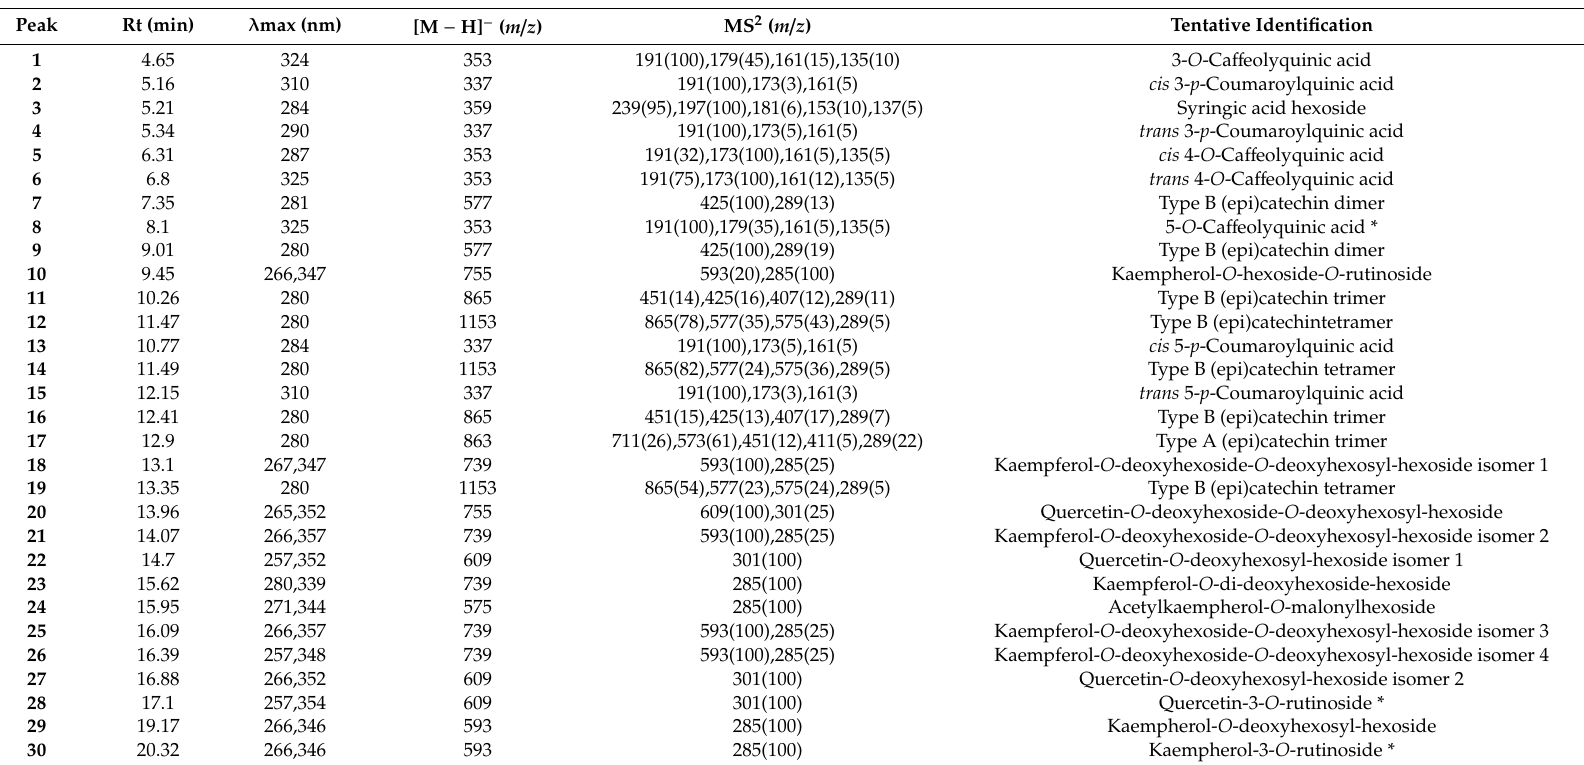
Table 1. Retention time (Rt), wavelengths of maximum absorption in the visible region ( λ max ), mass spectral data, and tentative identification of the phenolic compounds present in the hydroethanolic extracts of C. macrocarpa leaves, stems, and flowers. Peak Tentative